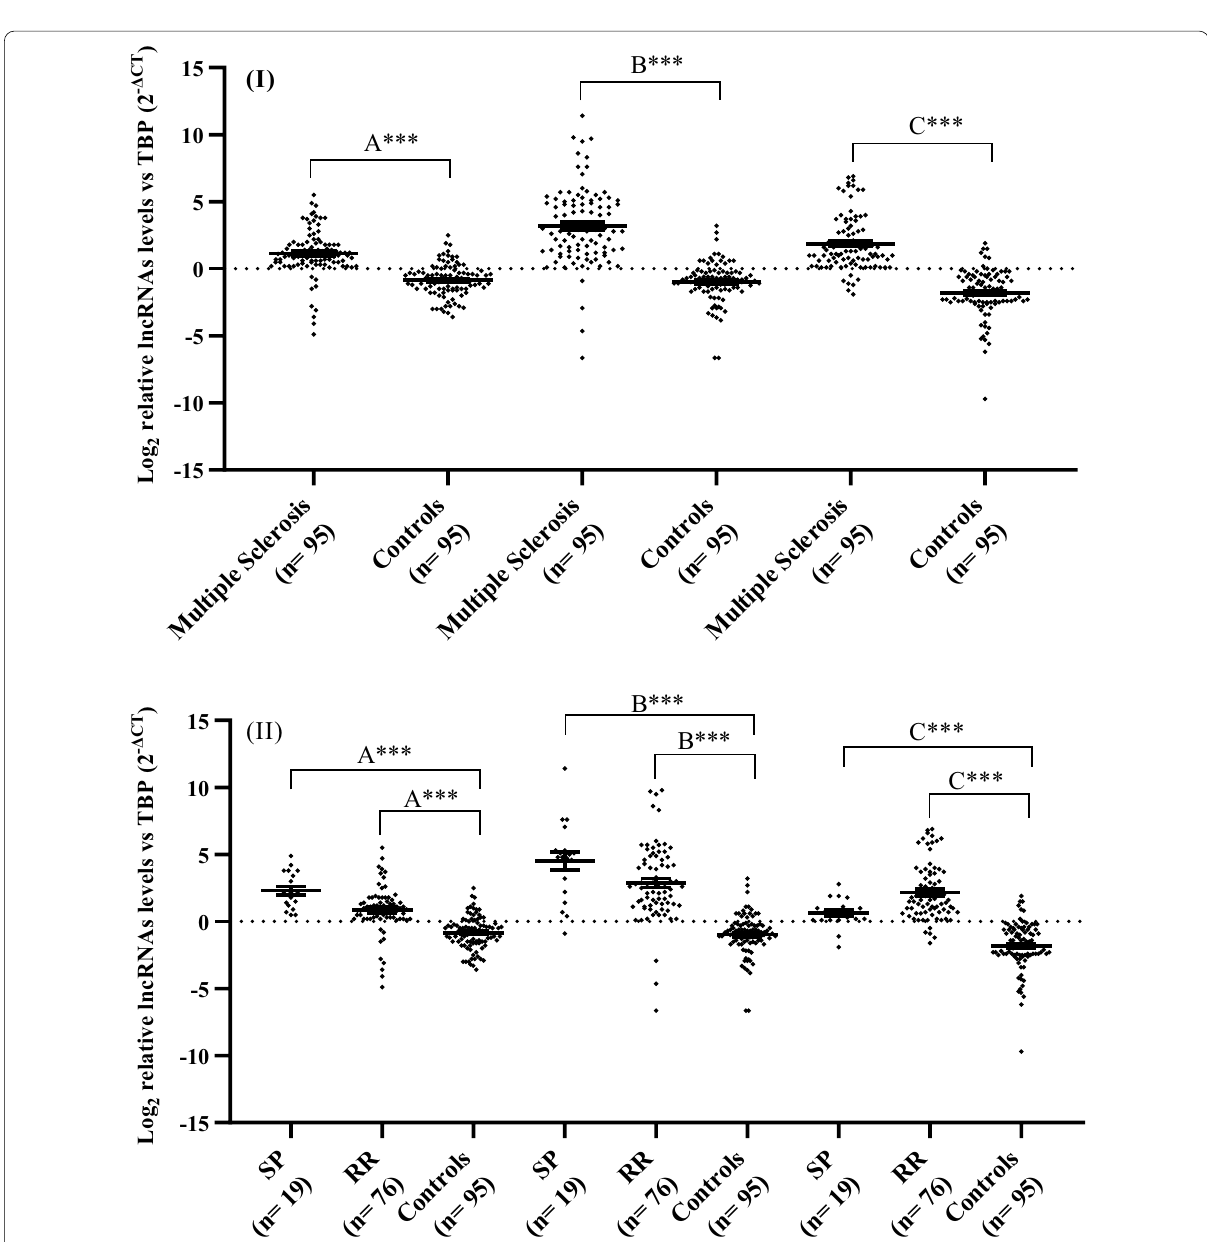
Fig. 1 The LncRNAs of MIAT, H19 and NRON versus the TBP gene levels in the MS cases and control, (I) the levels of MIAT ( A ), H19 ( B ), and NRON ( C ) in controls were significantly lower compared to MS patients, (II) the relative expression of MIAT ( A ), H19 ( B ), and NRON ( C ) (with log 2 fold change) in MS subgroups in comparison with normal healthy controls. Data were shown as mean t test or one‑way ANOVA. 2 − Δ Ct values for each individual were used to create each figure. *** P < 0.001 significant differences vs. control